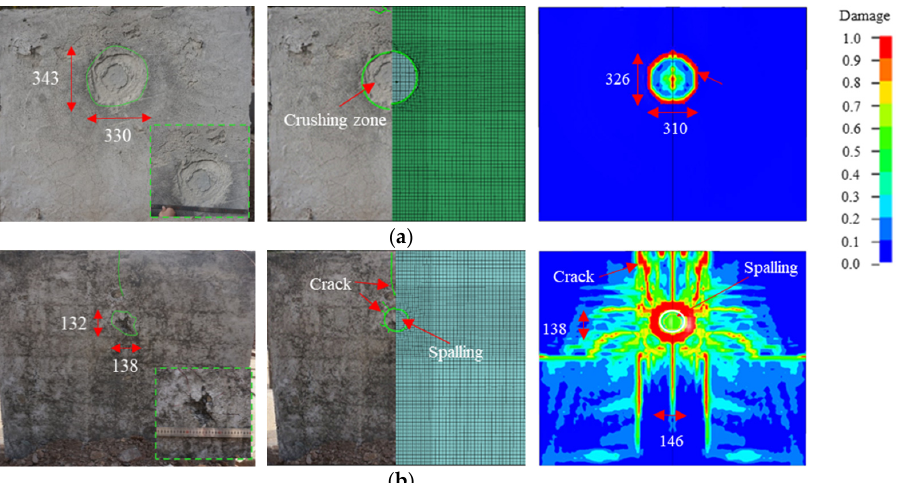
Figure 12. Experimental and simulation results for the damage of the 20 mm FC + SW wall (unit: mm): ( a ) Front side; ( b ) Back side.